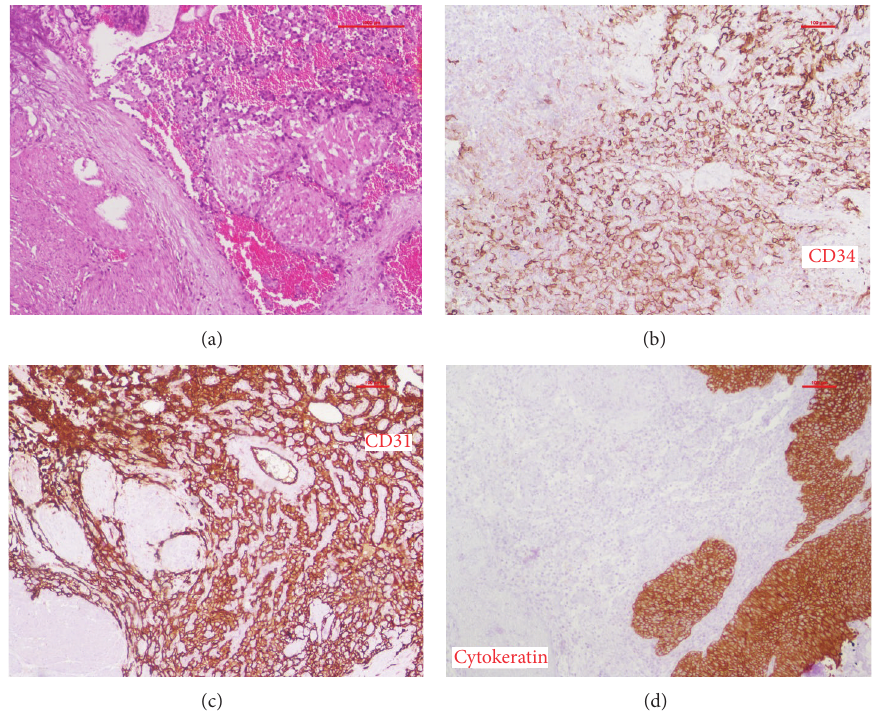
Figure 2: Histopathology and immunohistochemistry. (a) Typical appearance of anastomosing vascular channels as seen with H&E. (b) Tumor cells stain positive for CD34. (c) Tumor cells stain positive for CD31. (d) Tumor cells do not stain for